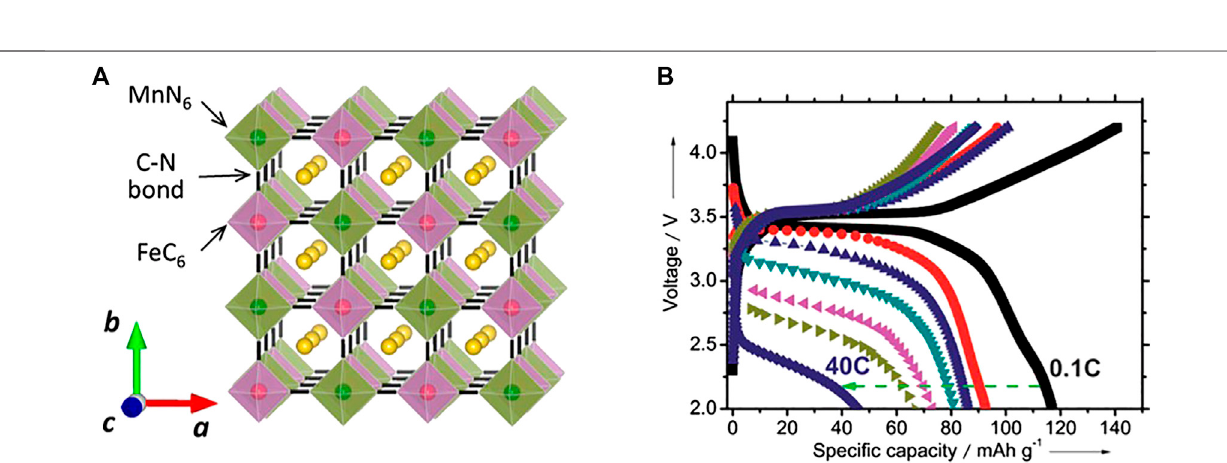
FIGURE 3 | (A) Crystal structure of NaxMnFe(CN)6, and (B) Electrode performance of NaxMnFe(CN)6 in Na cells. Reprinted with permission from ref. Yabuuchi et al. (2014)]. Copyright (2014) American Chemical